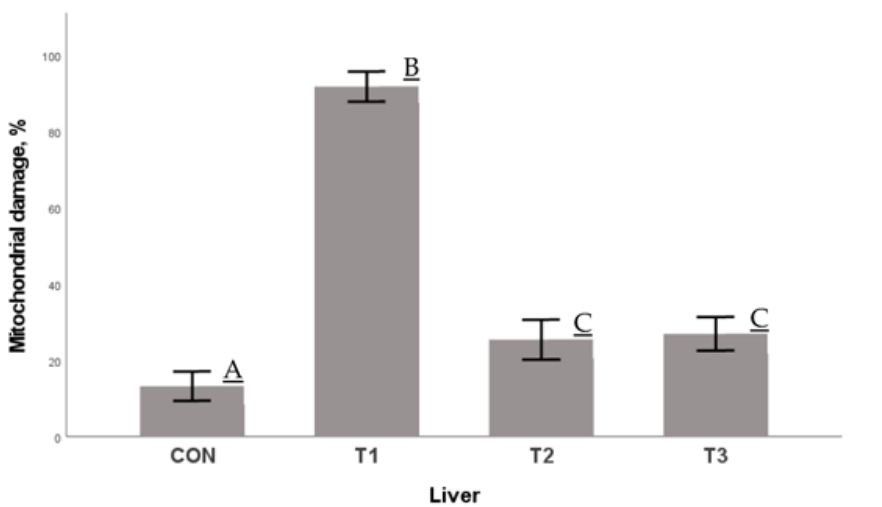
Figure 5. Mitochondrial damage in the liver. Data are given as mean ± SEM (n = 10); A, B, C —values denoted with various letters differ significantly at p ≤ 0.01; CON—control group; T1—diet with upper dose of inorganic Se (0.5 mg/kg feed); T2—diet with upper dose of Se in the organic form (0.5 mg/kg feed); T3—diet with upper dose of Se in the form of nanoparticles (0.5 mg/kg feed).